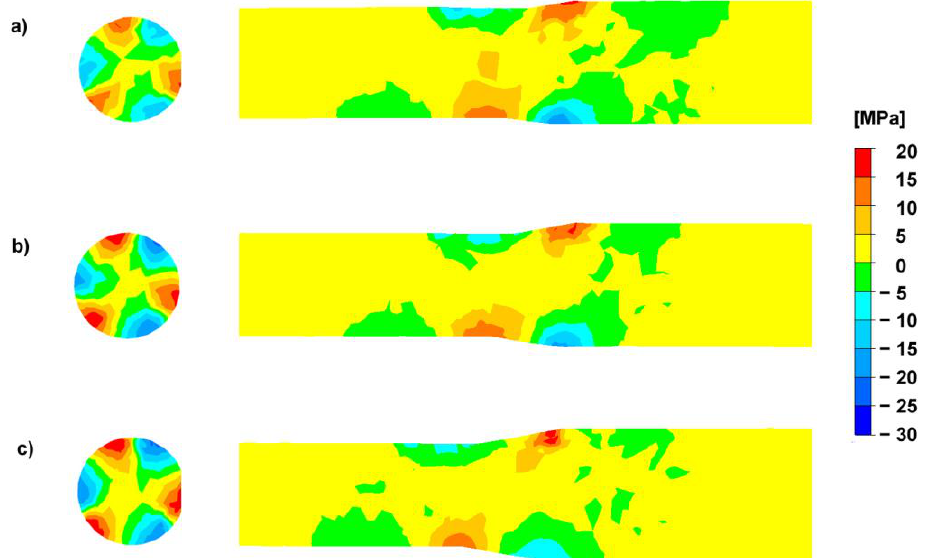
Figure 6. Distribution of the stress tensor component τ ρz for the RSR rolling process of AZ31 magnesium alloy bars: ( a ) Variant I, pass 3, ( b ) Variant II, pass 3, ( c ) Variant III, pass 2.